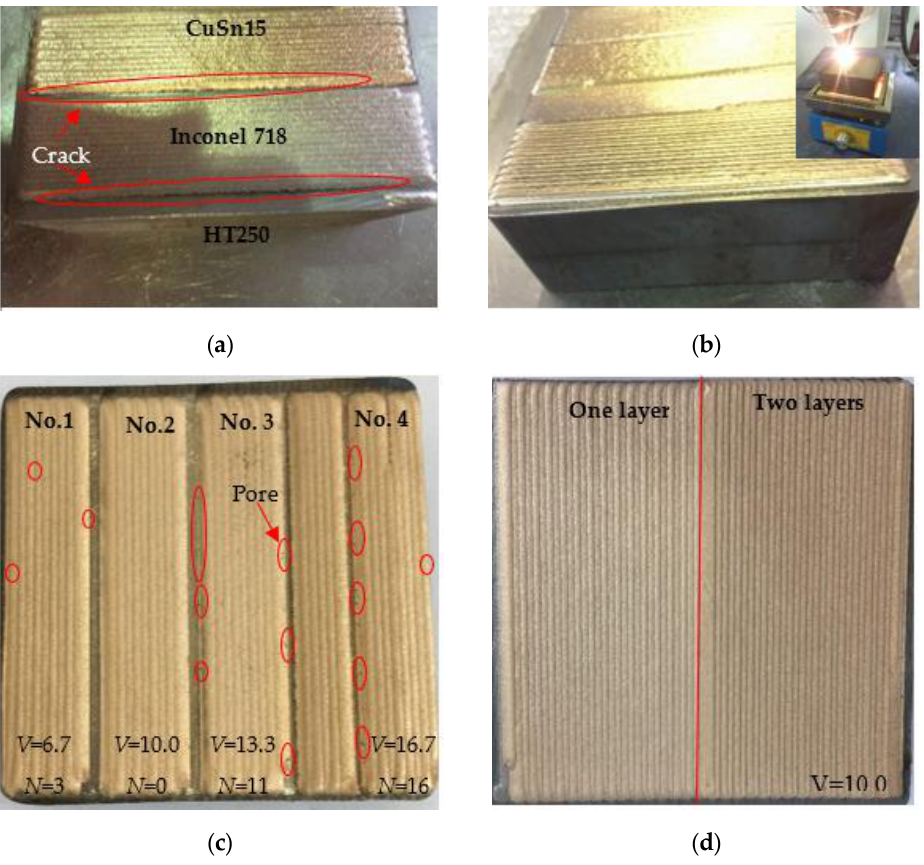
Figure 3. The morphology of the deposition layer. ( a ) Deposition layer obtained in the absence of heat; ( b ) deposition layer obtained under the conditions of preheating (300 °C) and slow cooling; ( c ) CuSn15 obtained via various scanning speeds; ( d ) CuSn15 with large area obtained with a scanning speed of 10.0 mm/s. Note: “V” denotes scanning speed and “N” means the number of pores. HT250 possessed inferior ductility under ambient temperature. In addition, the tensile strengths of CuSn15 and Inconel 718 were superior to that of HT250, making it easier for HT250 to be torn apart during the LDED process. Accordingly, the preheating and